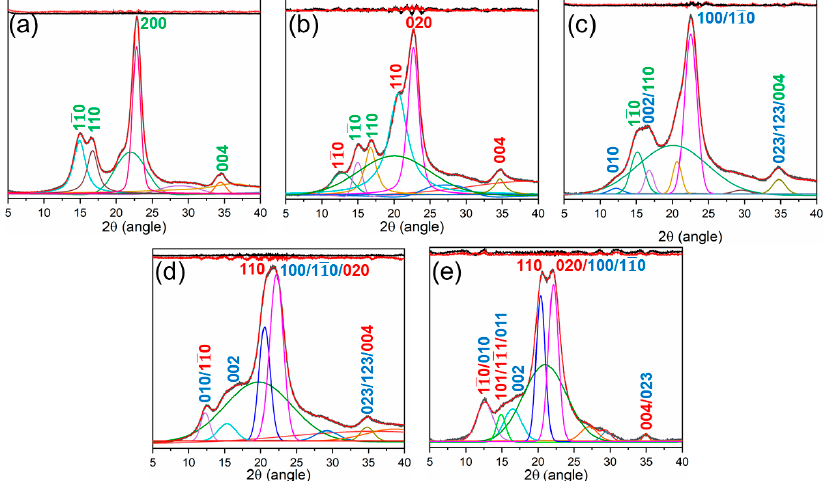
Figure 3. XRD analysis of ( a ) the untreated, ( b ) CM, ( c ) LA, ( d ) CM/LA, and ( e ) LA/CM samples with Miller indices: cellulose I (green labels), cellulose (red labels) and cellulose III (blue labels).